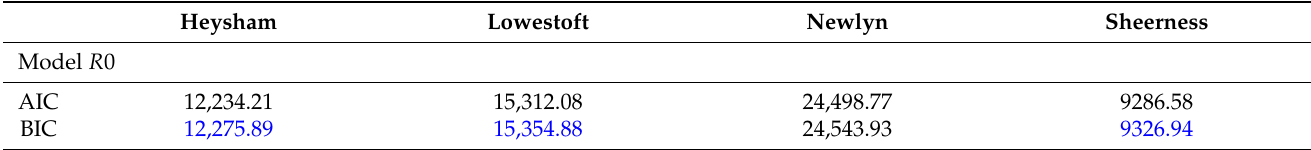
Table 2. Parameter estimates for the Models R 1 − R 4 with AIC and BIC scores for each model fit at each site (including Model R 0). The minimum AIC and BIC scores are highlighted in red and blue, respectively, for each site. The 95% confidence intervals are given in parentheses for parameter